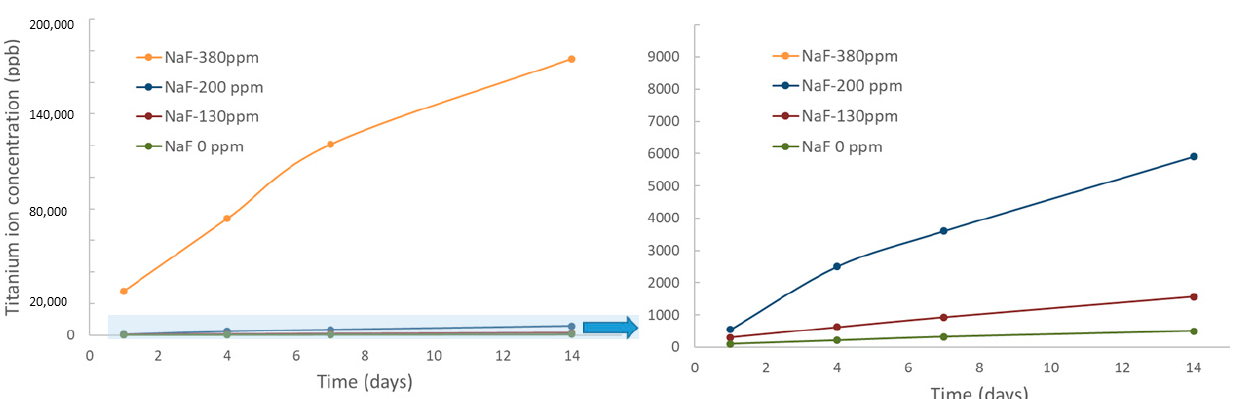
Figure 2. Ti ion release in ppb at different immersion times for each mouthwash studied. The shaded area is enlarged for the 0, 130 and 200 ppm NaF concentrations.